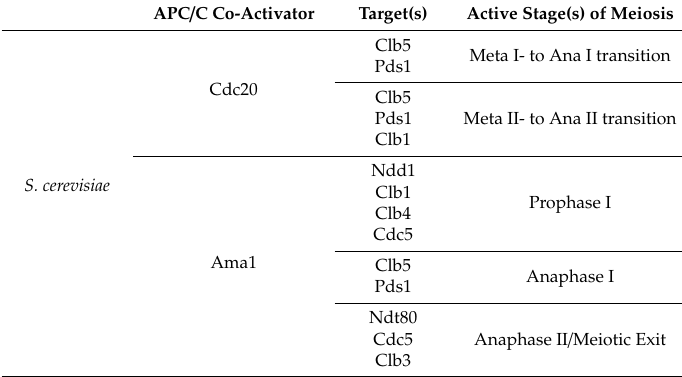
Table 1. Anaphase Promoting Complex / Cyclosome (APC / C) Co-activators and their Cell Cycle Targets in